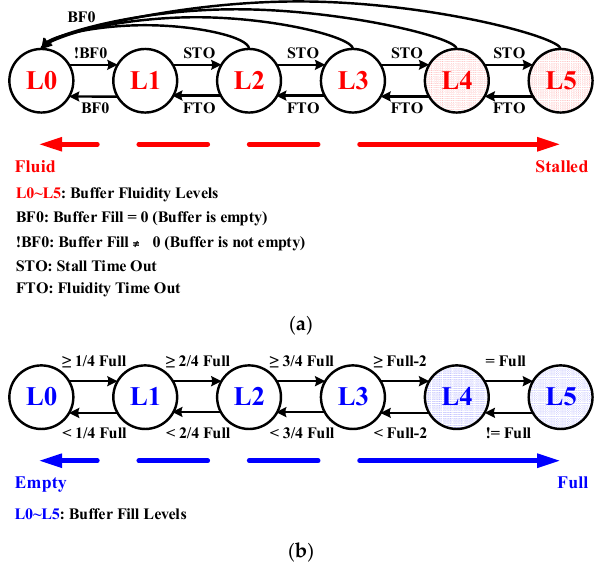
Figure 10. A Buffer Cognition Monitor (BCogM) consisted of State Machines (SMs) monitoring ( a ) the Buffer Fluidity Level (BFluL) and ( b ) the Buffer Fill Level (BFilL). Table 1. Buffer Fluidity Level (BFluL).